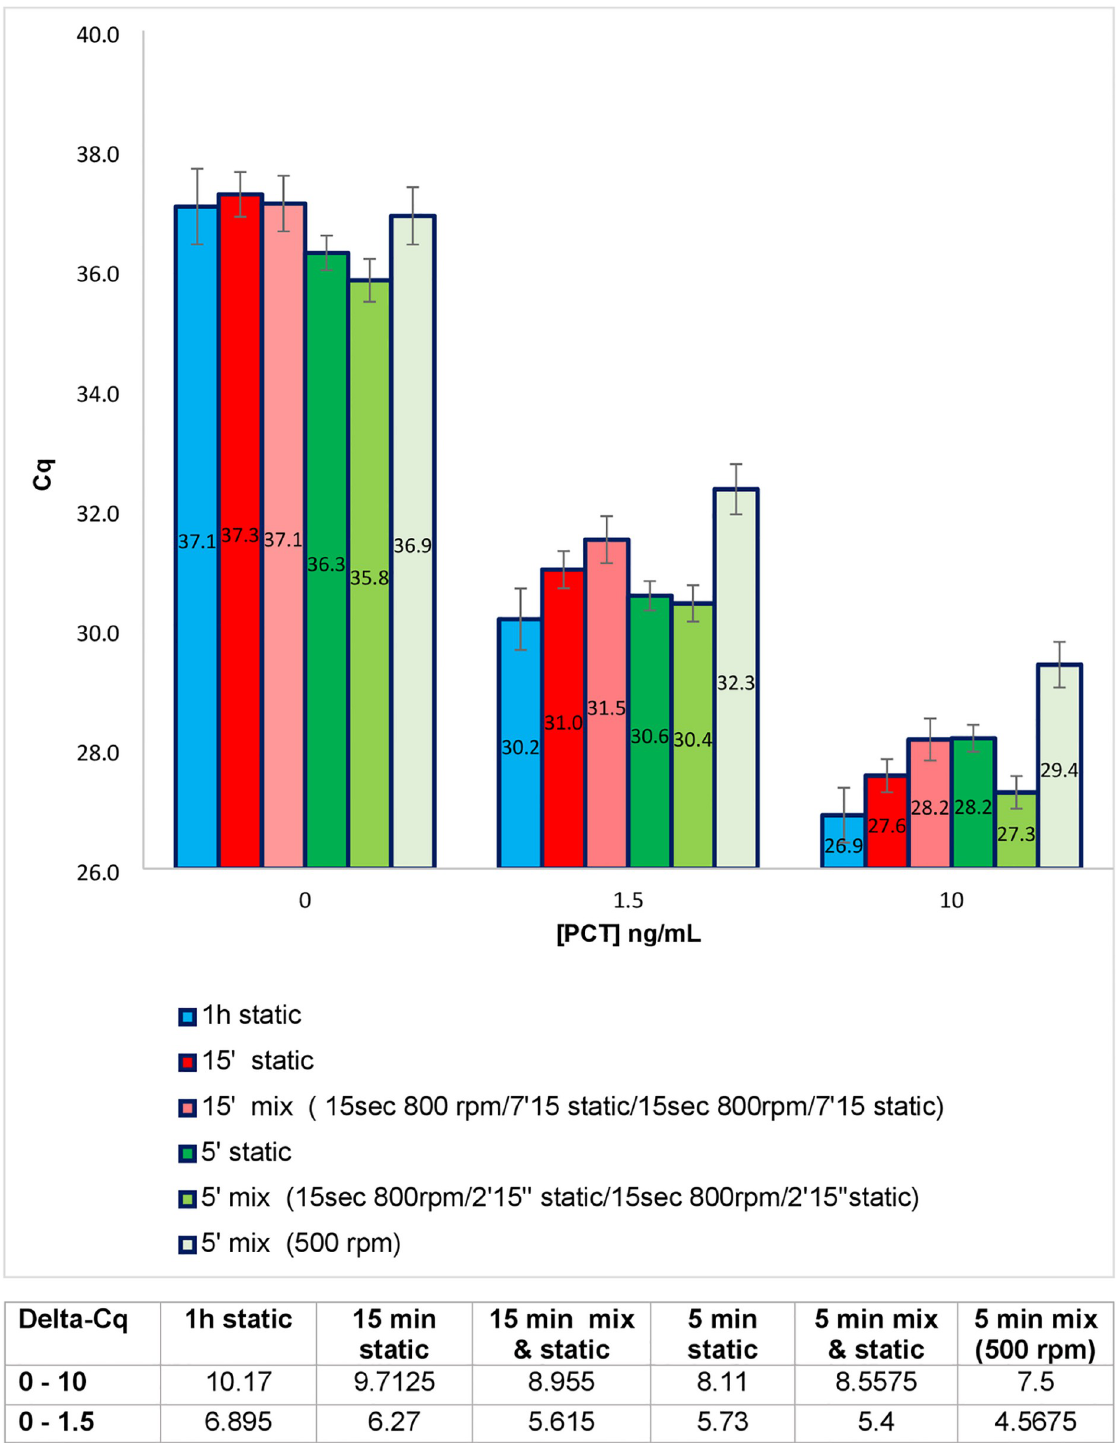
Fig 3. Effect of plate agitation on PEA performed for different durations of antigen/antibody binding for three concentrations of rPCT. The incubation time between the rPCT and the PEA probes was progressively decreased from 1h (reference test) down to 5 minutes. The incubation was performed at 37˚C under static conditions (static) or with agitation of the multi-well plate in a thermomixer. Two alternative mixing conditions were tested: one with continuous agitation at 500 rpm, the other with phases of agitation at 800 rpm alternating with phases without agitation (static). The results, given in Cq values, correspond to the mean of a minimum of three duplicate